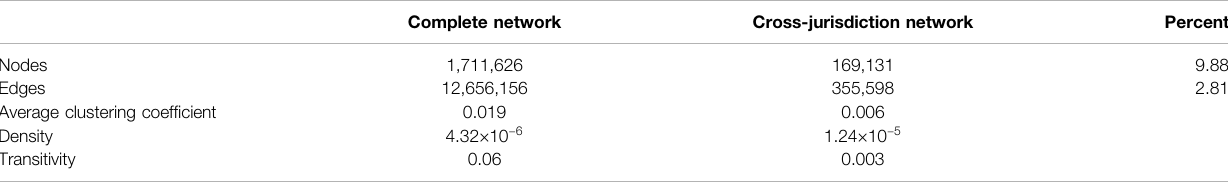
TABLE 2 | Properties of the complete and cross-jurisdictional